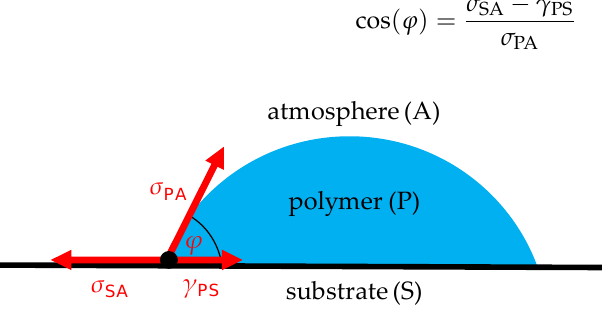
Figure 1. Polymer drop on substrate surface.